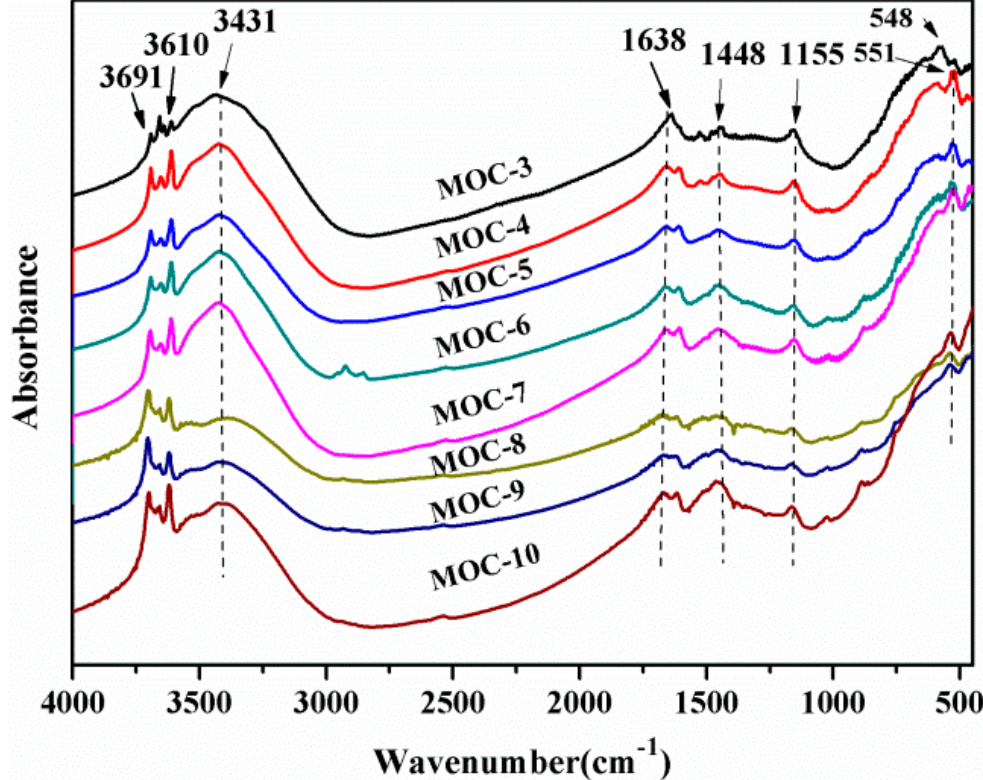
Figure 1. Fourier Transform Infrared (FTIR) spectra of MOC adhesives.